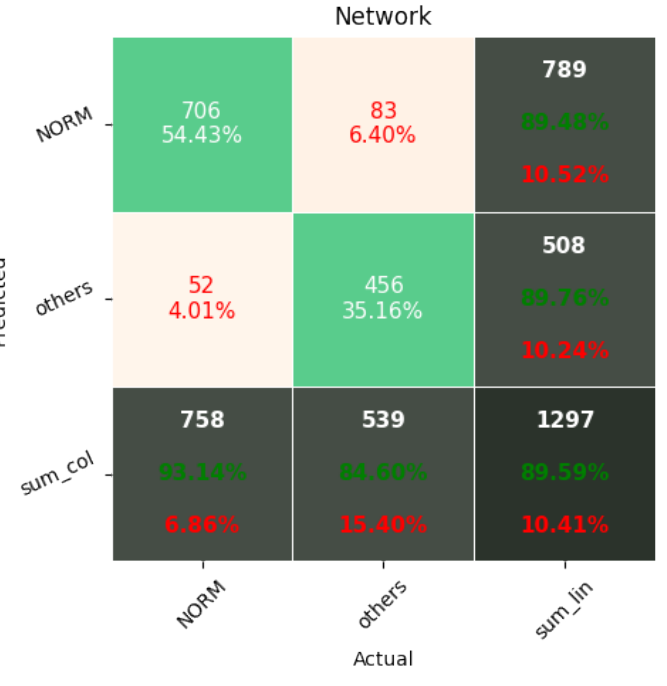
Figure 9. Confusion Matrix for Few-Shot (2 classes) with proximity-based classification.